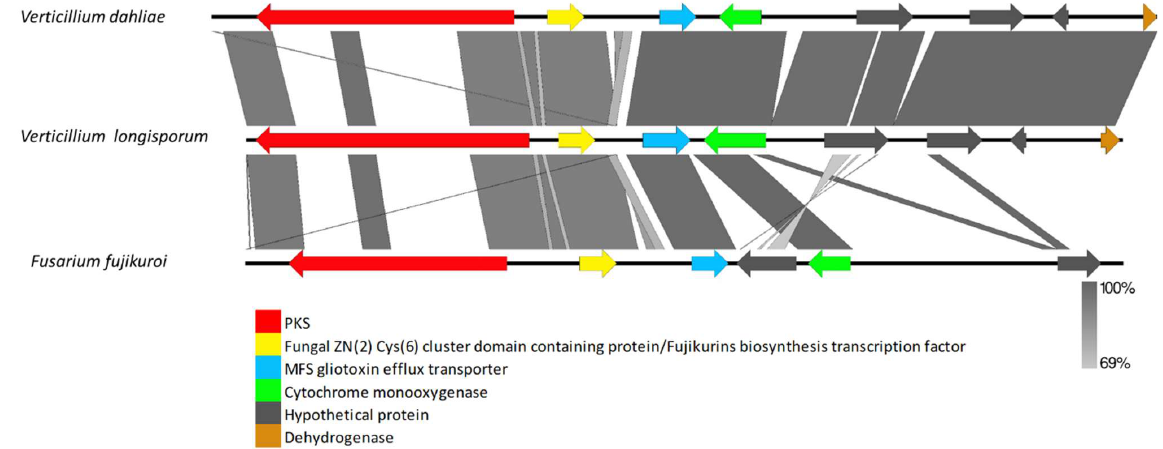
Figure 6. Comparison of V. dahliae and V. longisporum genes flanking VRPKS-I-8 PKSs that are closely related homologs of fujikurin synthase gene cluster from Fusarium fujikuroi . The arrowheads indicate the direction of transcription and the types of genes common to the two clusters being compared are displayed in the same color. Shaded lines represent similarities between nucleotide sequences.